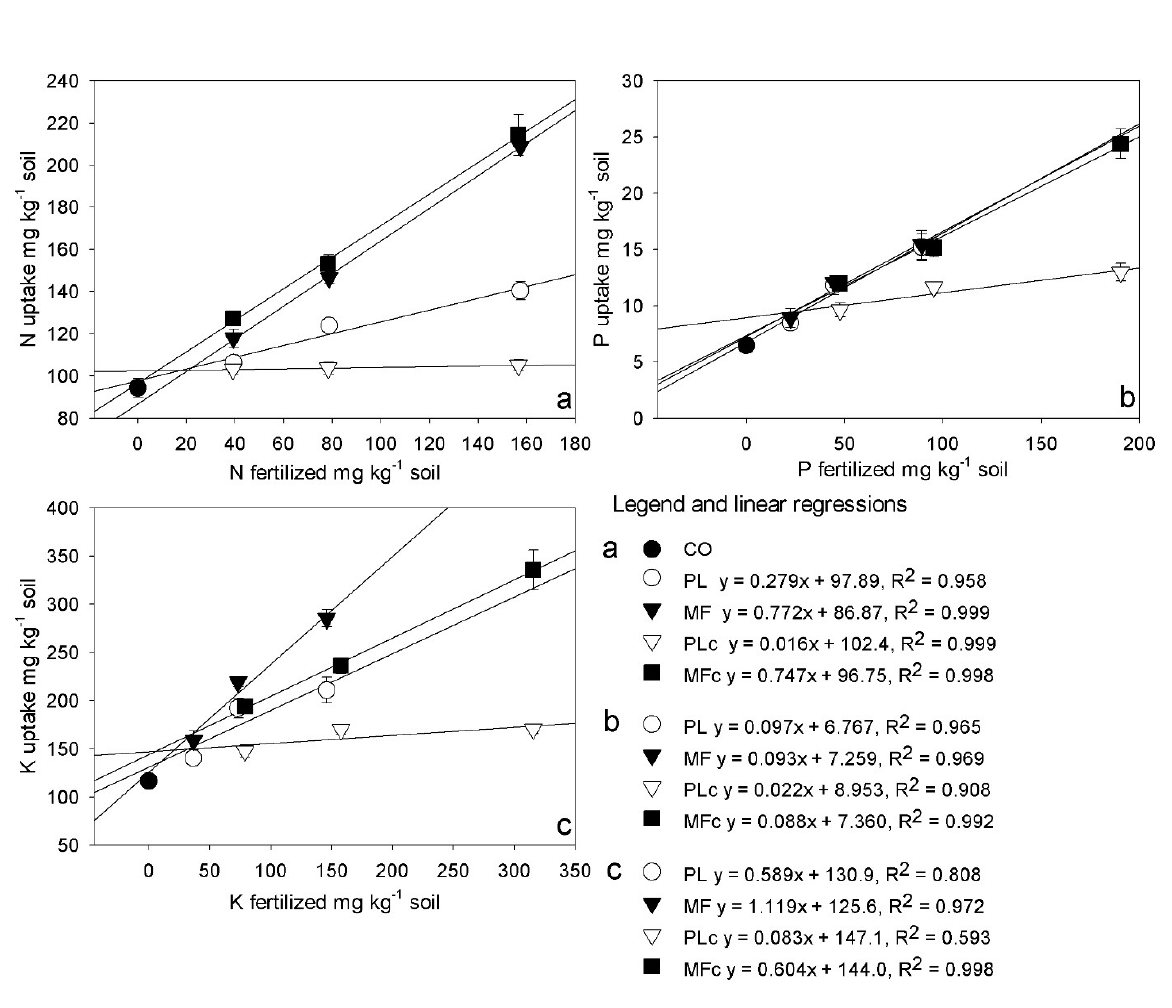
Figure 1: Regressions of nutrients (N, P, and K) fertilized and cumulative uptake up by ryegrass ( Lolium perenne ) per kg of soil after 4 conse- cutive harvests. CO = control, PL = poultry litter, MF = mineral fertilizer, PLc = carbonized poultry litter MFc = mineral fertilization based on PLc, means and standard errors, n = 4.